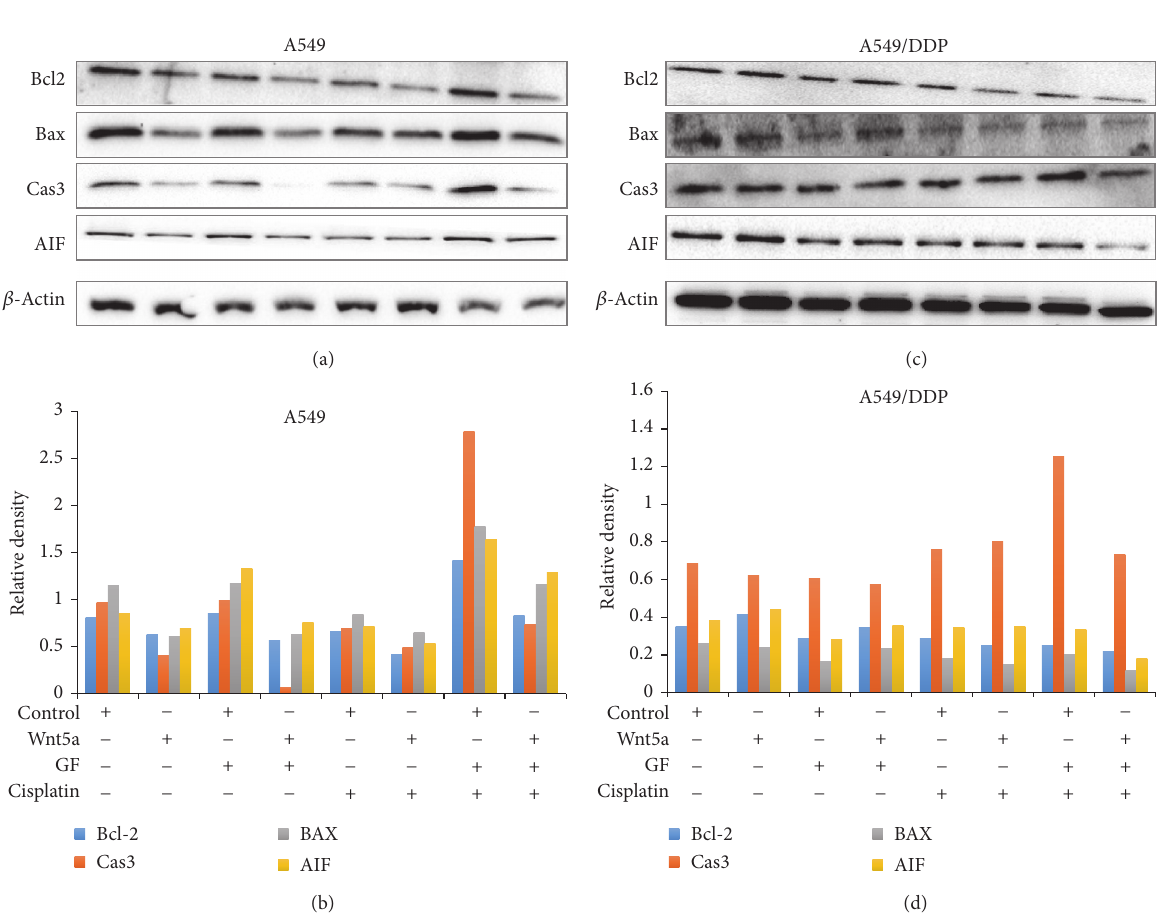
Figure 8: Apoptosis related proteins determined by an immunoblotting analysis. A549 and A549/DDP cells were cultured in medium containing Wnt5a, PKC inhibitor GF109203X, and/or cisplatin for 24 hours; the cells were then harvested for immunoblotting analysis of indicated proteins. (a) Representative images of immunoblotting analysis in A549 cells. (b) The relative levels of proteins detected as evaluated by a densitometric analysis for proteins of interest of A549 cells in (a). (c) Representative images of immunoblotting analysis in A549/DDP cells. (d) The relative levels of proteins detected as evaluated by a densitometric analysis for proteins of interest of A549/DDP cells in (c). An exposure of A549/DDP cells to Wnt5a reduced the expression of proapoptotic proteins (caspase 3, Bax, and AIF) but increased the expression of antiapoptotic protein Bcl-2 in lung cancer cells. Cas3: caspase